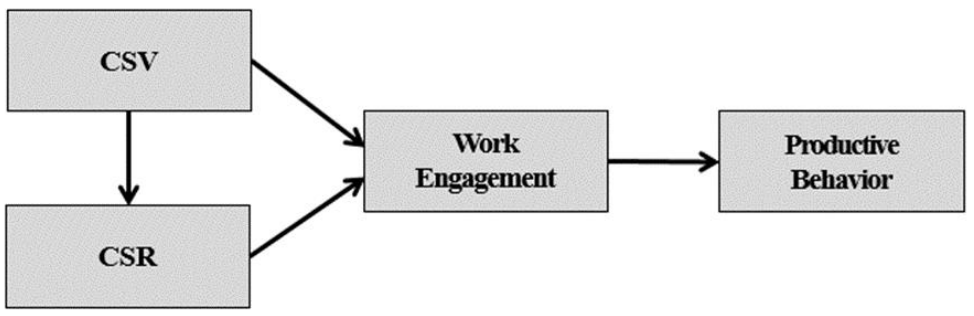
Figure 1. Conceptual research mode.